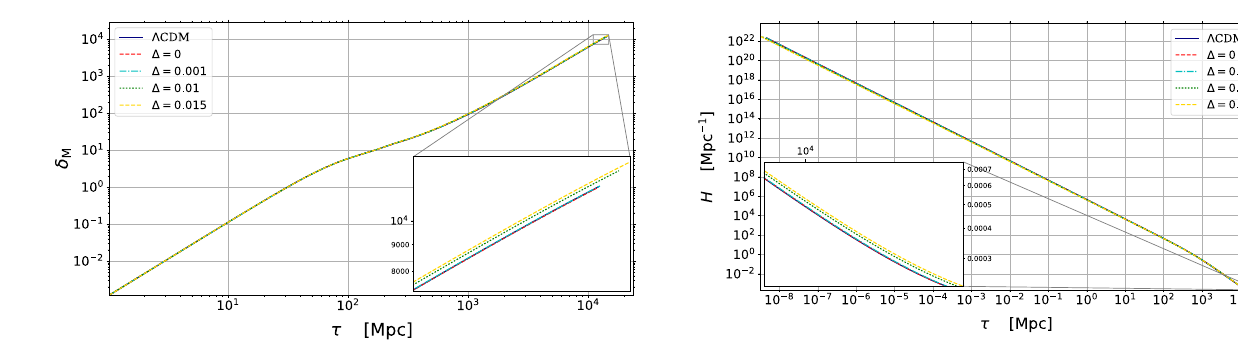
Fig. 2 Matter density contrast diagrams in terms of conformal time in Barrow cosmology compared to (cid:3) CDM